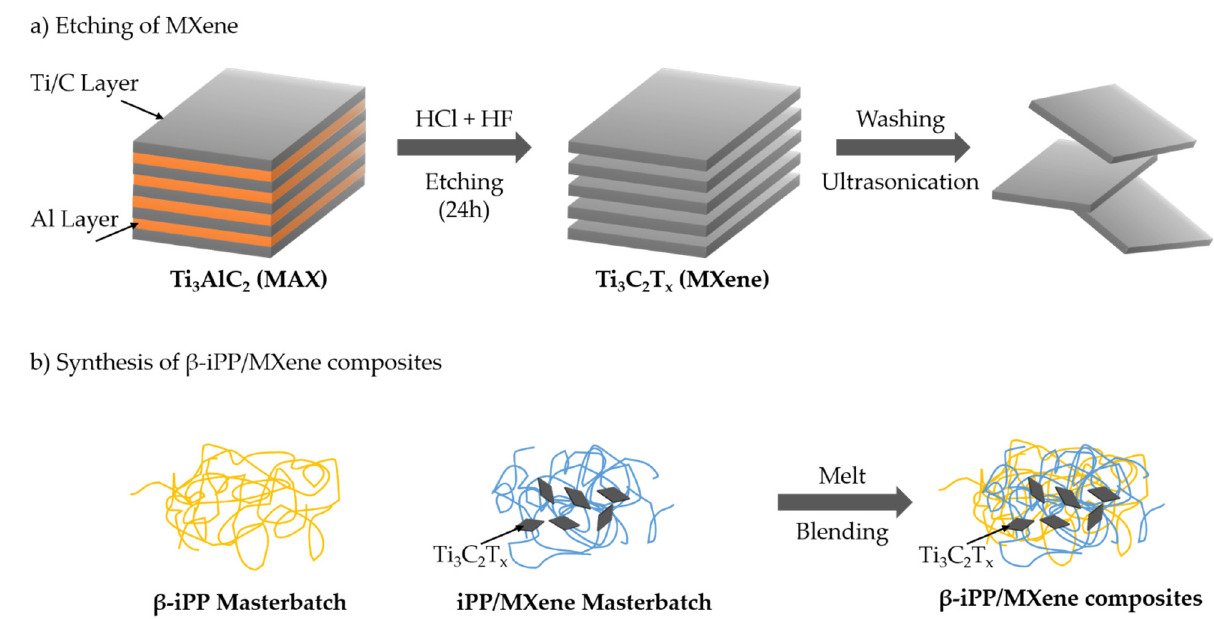
Figure 1. Schematic diagram of etching MXene and synthesis of β -iPP/MXene composites.